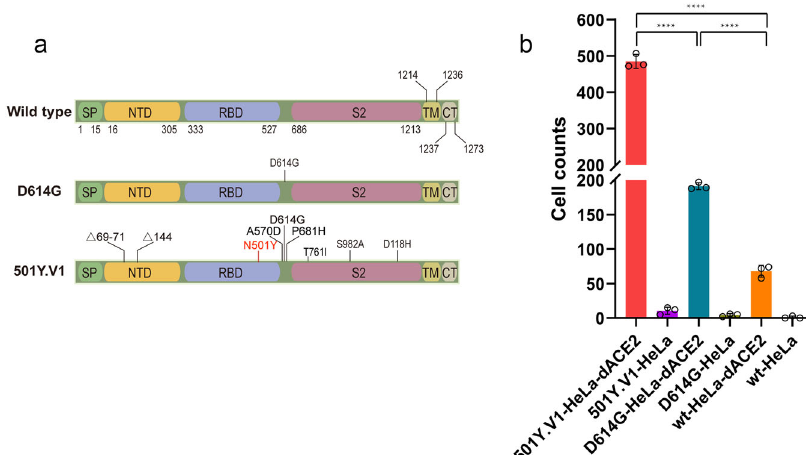
Fig. 5 D614G, N501Y.V1 variant pseudovirus infection of the dACE2-HeLa cell line. a Schematic of SARS-CoV-2 S wt and the D614G and N501Y.V1 variants. b The dACE2-HeLa cell line was infected with pseudoviruses with SARS-CoV-2 S protein from D614G, N501Y.V1 variants and the wt virus. The number of cells with green fl uorescence were counted. Data are presented as mean values± SD of triplicate cell samples. **** p < 0.0001; two-tailed Student ’ s t